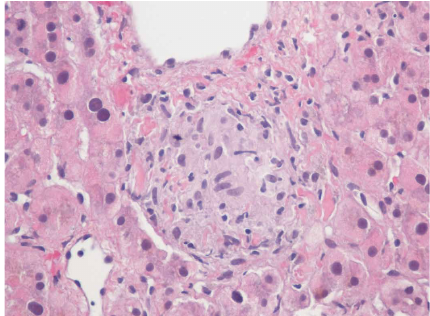
Figure 4: Liver biopsy with nonnecrotizing granuloma. Composed of lymphohistiocytic collections. ( 𝐻 and 𝐸 , magnification ×400).